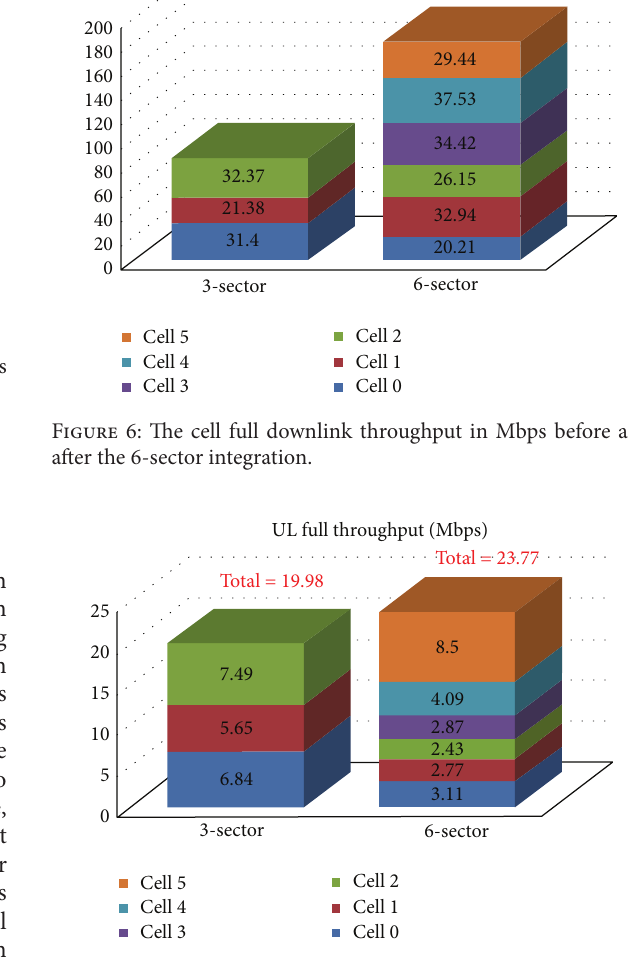
Figure 7: The cell full uplink throughput in Mbps before and after the 6-sector